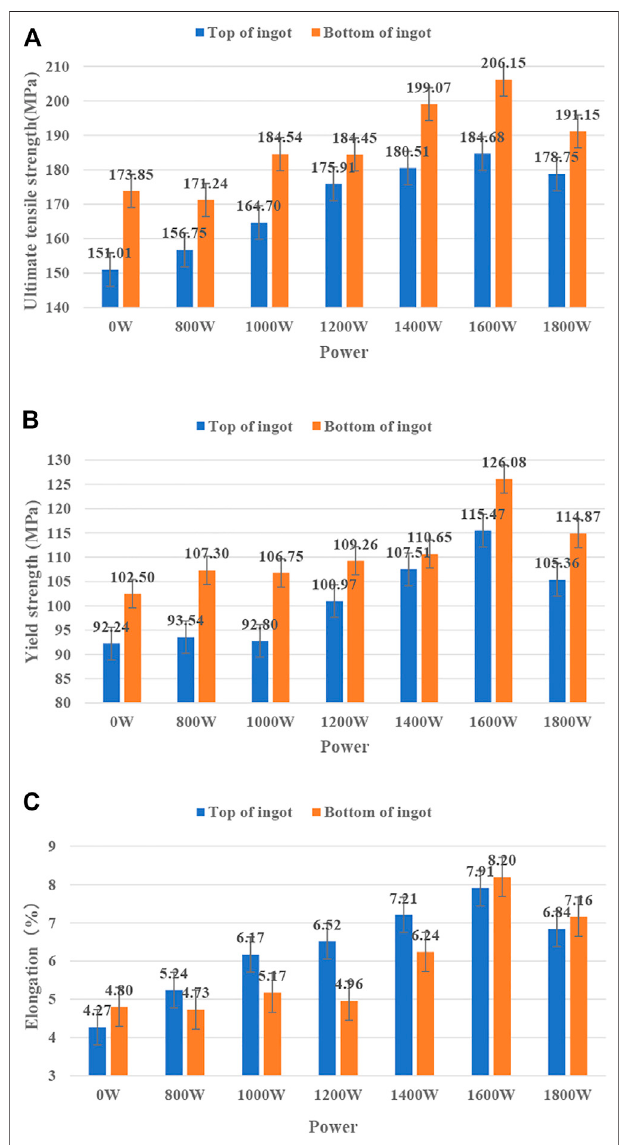
FIGURE 9 | (A) Ultimate tensile strength processed under different ultrasonic (B) yield strength and (C) elongation determined from different positions of the